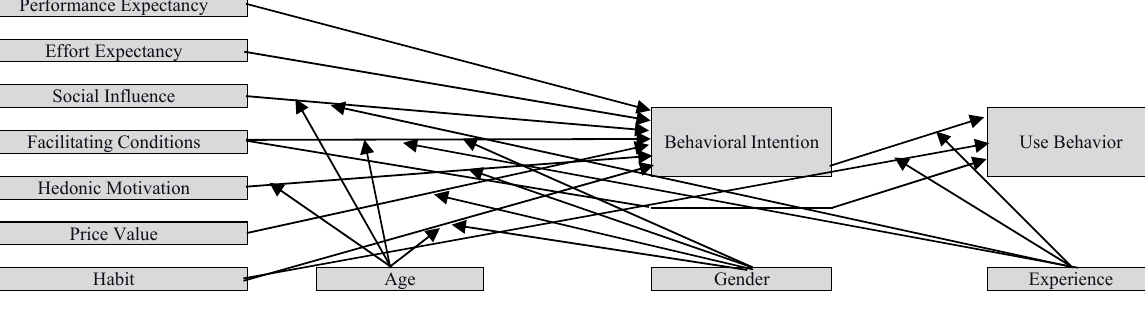
Fig 1. UTAUT2 model. (Venkatesh et al.,